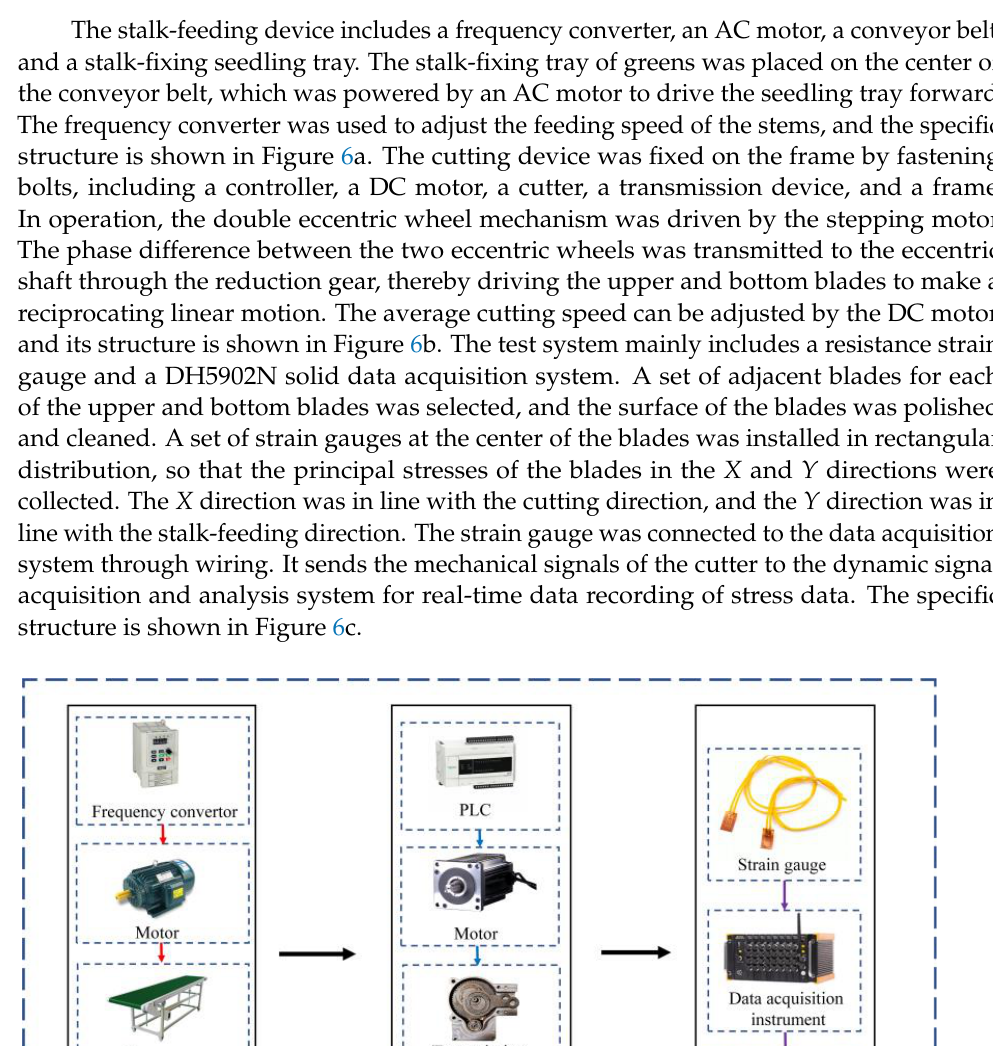
Table 4. Parameters of the reciprocating cutting test system.